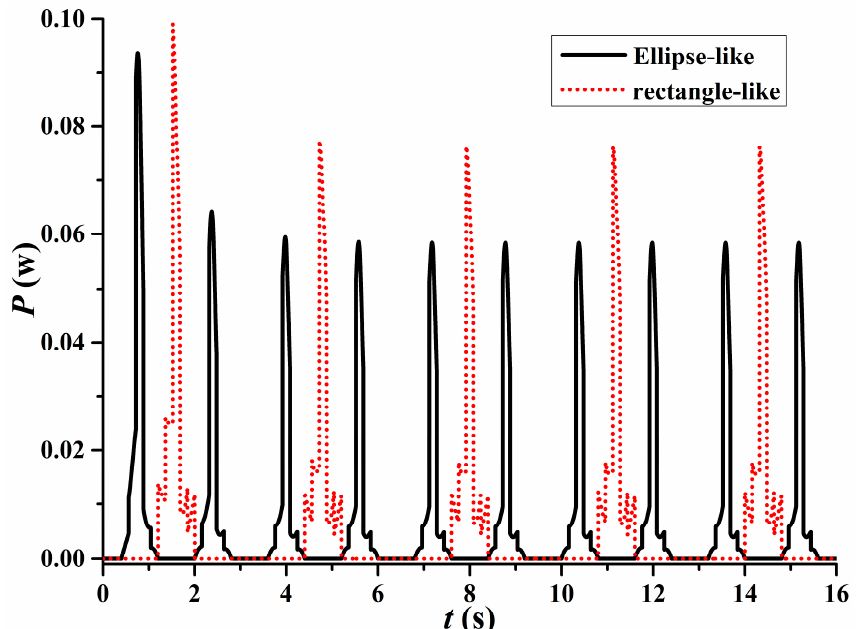
Figure 15. The powers of the robot P when the paddles perform an ellipse-like spatial stroke trajectory and rectangle-like spatial stroke trajectory as a function of the running time t .